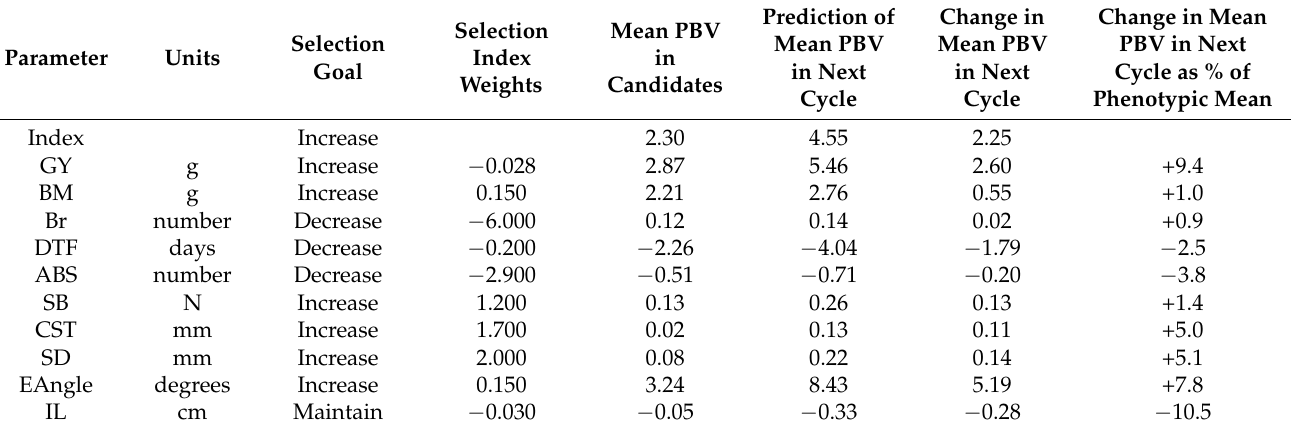
Table 4. Predictions of genetic gains in index and PBVs in the next cycle of the experimental field pea population, from optimal contribution selection using MateSel [45]. The population phenotypic means for each trait are shown in Supplemental Table